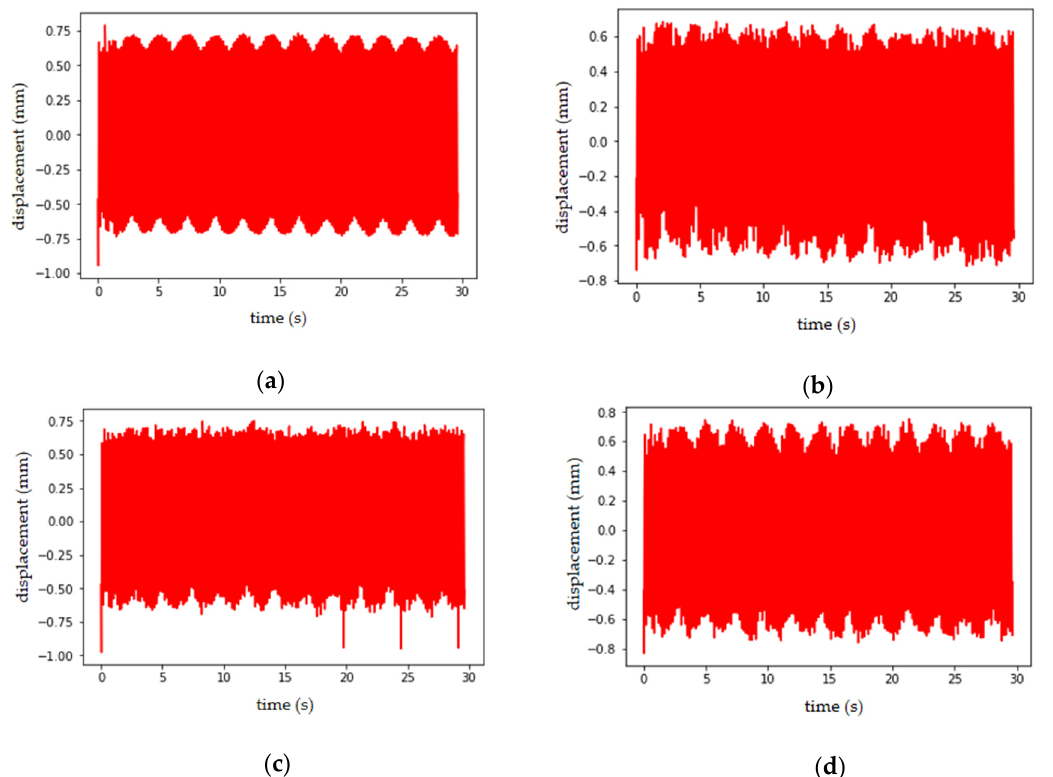
Figure 17. Vertical displacement amplitude diagram: ( a ) the vertical displacement amplitudes obtained when the input is a whole image; ( b ) the vertical displacement amplitudes obtained when the input is bolt P 1 ; ( c ) the vertical displacement amplitudes obtained when the input is bolt P 2 ; ( d ) the vertical displacement amplitudes obtained when the input is bolt P 3 . Table 4. Calculation times of input different images.